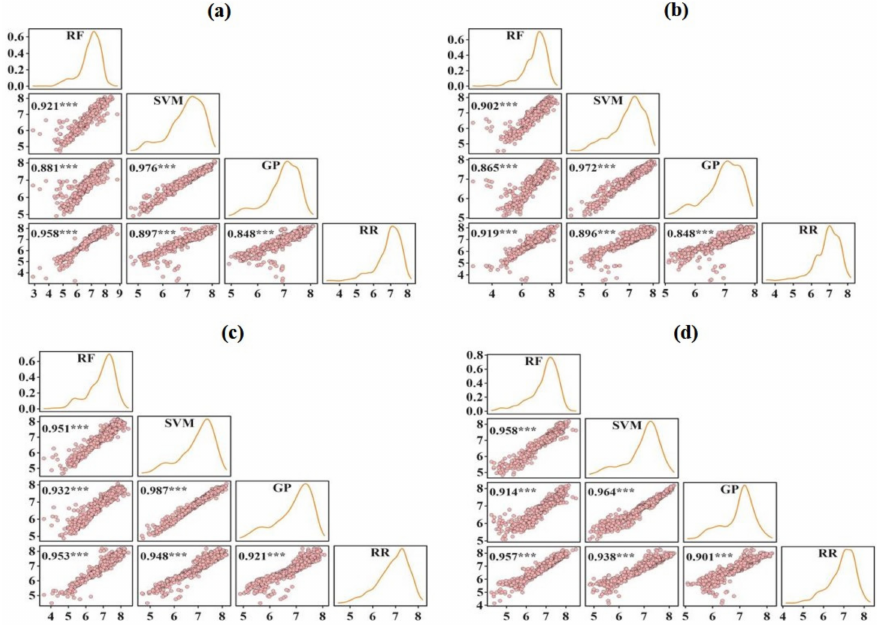
Figure A2. Regression plots, density curves, and correlation coefficient of grain yield prediction generated by various machine learning methods at four growth stages under limited irrigation treatment; ( a ) heading stage; ( b ) flowering stage; ( c ) early grain filling stage; ( d ) mid-grain filling stage significant (***) at p < 0.001. Abbreviations: RF, random forest; SVM; support vector machine; GP, Gaussian process; and RR, ridge